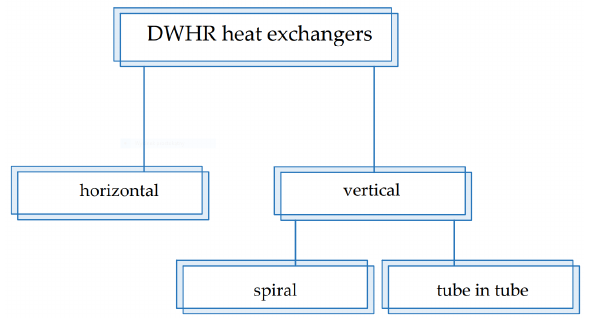
Figure 4. Division of DWHR heat exchangers [46 – 49].